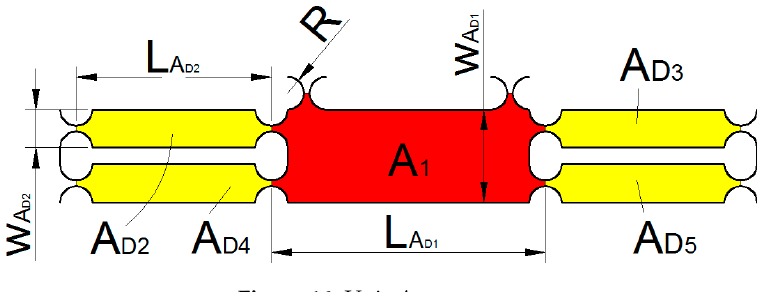
Figure 16. Unit A D structure. Figure 16. Unit 𝐴 (cid:3005) structure.